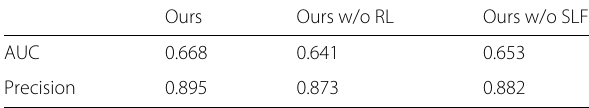
Table 1 AUC score and precision at a threshold of 20 pixels on the OTB100 dataset for the ablation analysis on the ranking loss (denoted by RL) and spatial location feature (denoted by SLF)